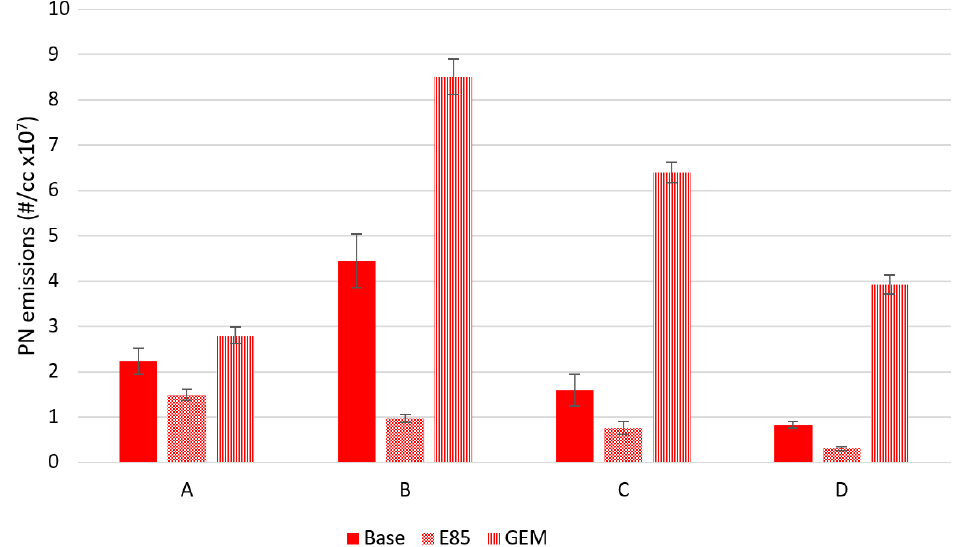
Figure 11. PN emissions at maximum torque for standard gasoline and two high-alcohol blends at four di ff erent fixed-intake conditions. The GEM blend has the highest PN emissions. The error bars correspond to ± σ .